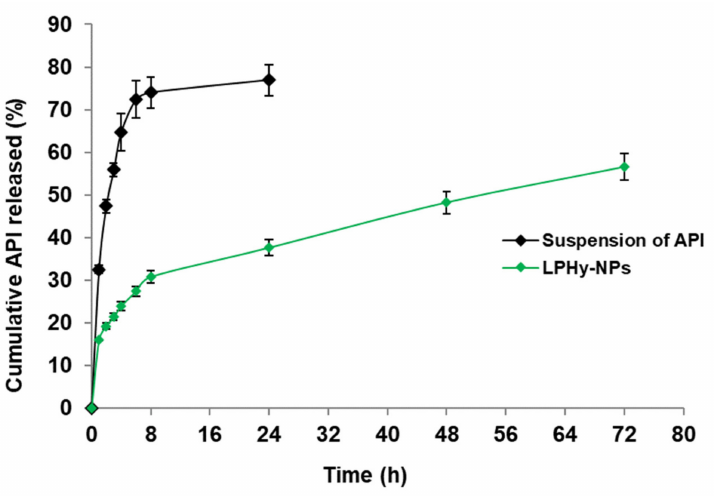
Figure 6. In vitro release of AGN from LPHyNP and suspension of AGN in PBS containing SLS (1%) as a solubilizer by dialysis bag